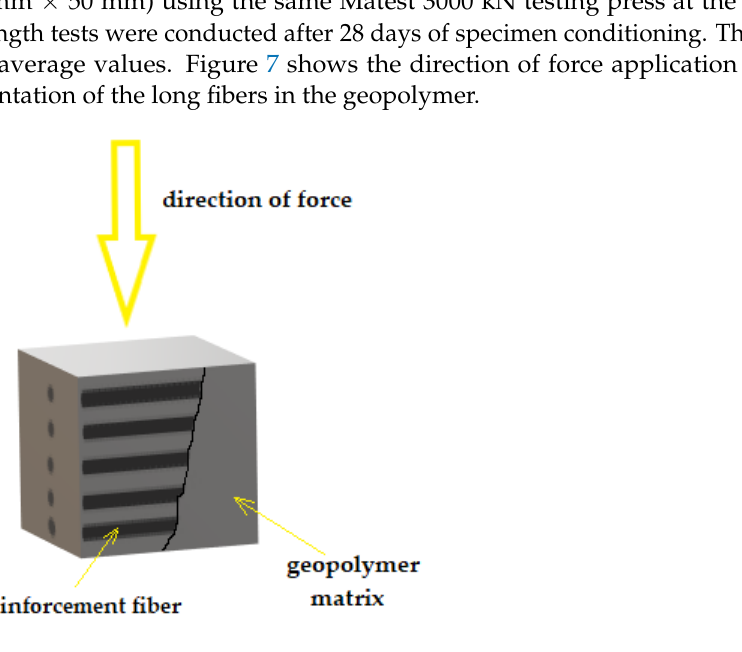
Figure 7. Way of applying a force to a sample reinforced with long fibers.